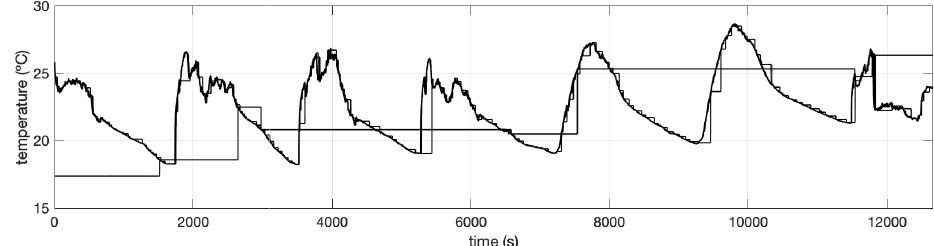
Figure 11. Training data set obtained from the Intel Lab WSN with N = 54 sensor